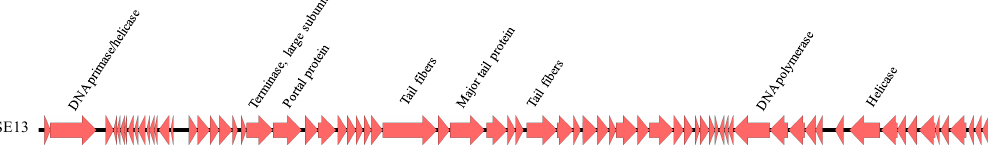
Figure 3. Linear whole-genome representation of phage SE13. Large open reading frames (ORFs) greater than 1000 bp are indicated. Arrows indicate the direction of